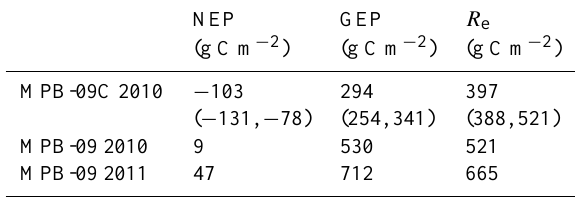
August and September coincided with warm soil conditions